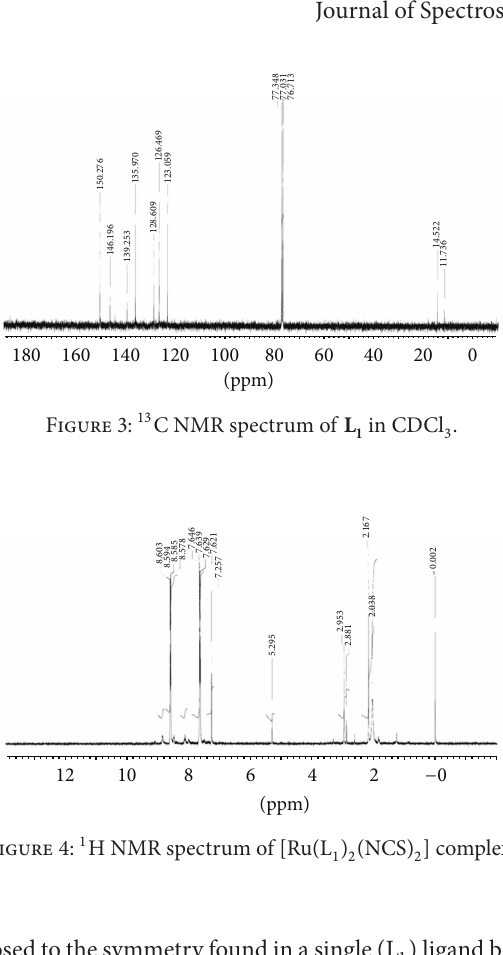
Figure 2: 1 H NMR spectrum of L 1 in CDCl 3 .